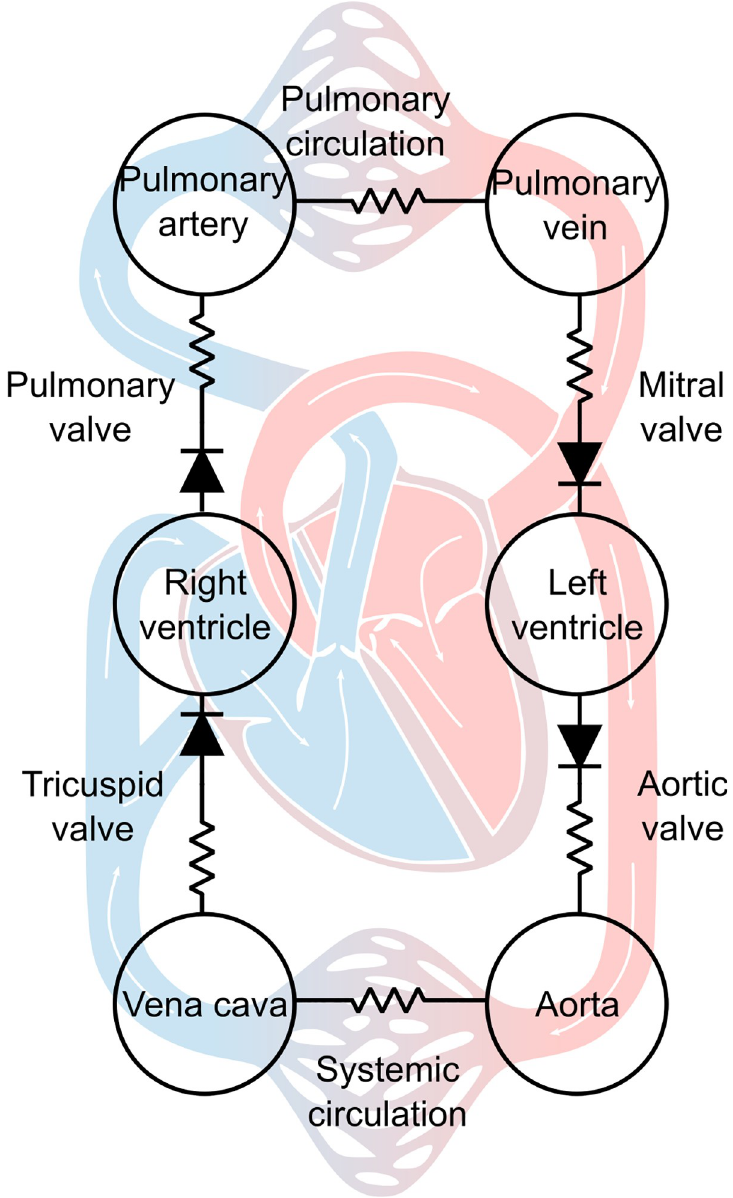
Fig 2. 6-chamber lumped-parameter model of the cardiovascular system. Ventricular contraction is described at the cellular scale. The left and right ventricles are assimilated to spheres, and the force and length of a half-sarcomere are connected to the pressure and volume within the ventricular